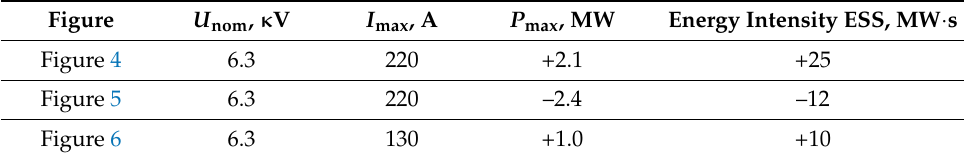
Table 1. Specifications to be met by the ESS in the power supply system with